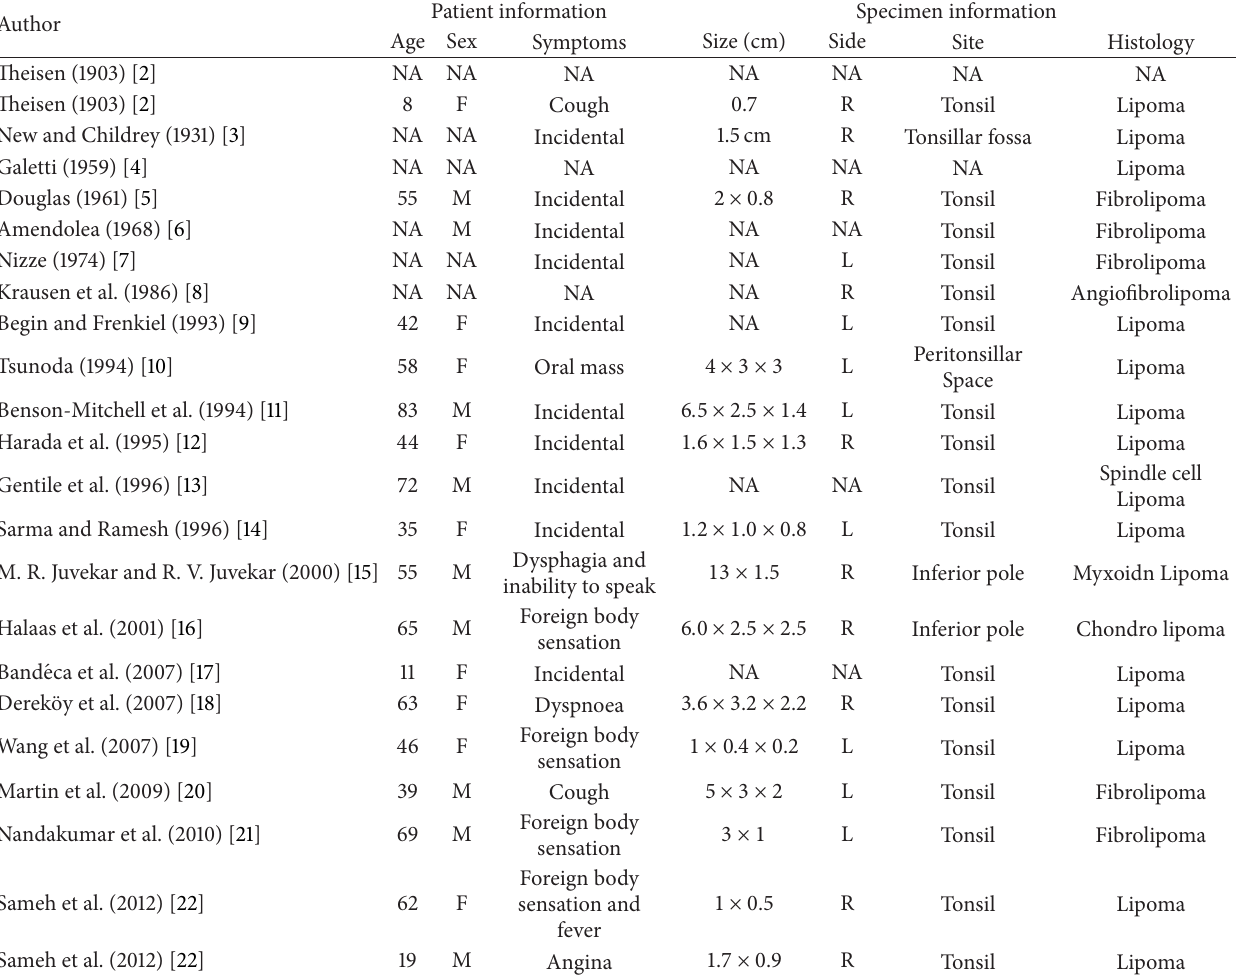
Table 1: Summary of tonsillar lipoma case reports including patient demographics, clinical features, and specimen